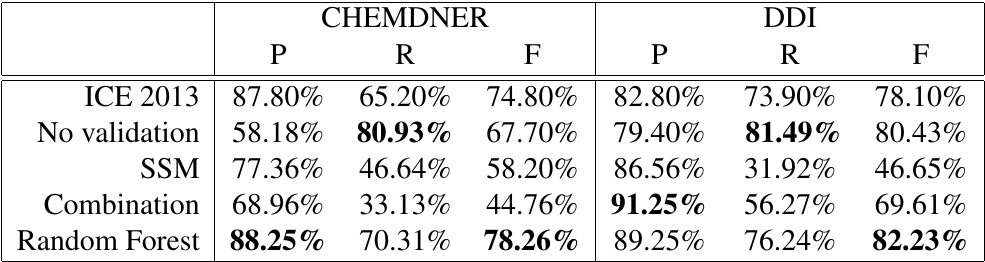
Table 4: Precision, Recall and F-measure estimates for NER using different validation processes, on the test set of the CHEMDNER and DDI corpus. Bold values are the maximum values in each